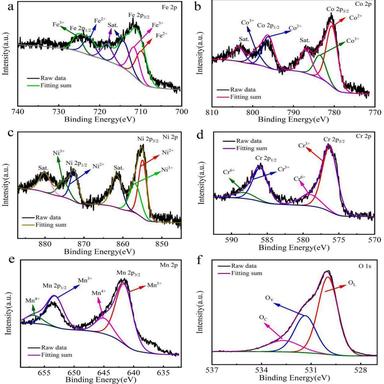
XPS spectrogram of (FeCoNiCrMn)3O4 HEO: (a) Fe 2p, (b) Co 2p, (c) Ni 2p, (d) Cr 2p, (e) Mn 2p, (f) O 1s.